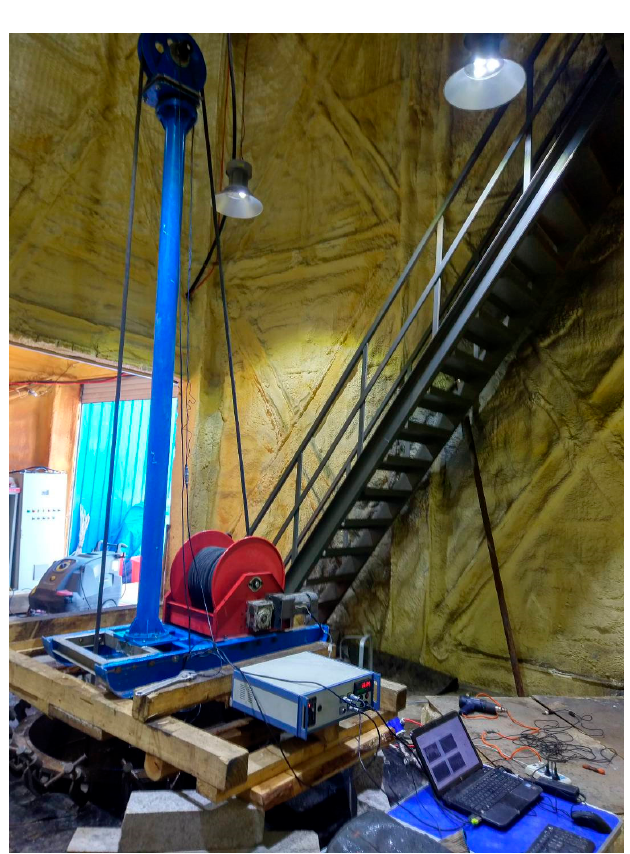
Figure 11. JLU shallow, hot-water, ice-drilling system installed on the drilling testing facility (for more details see Talalay et al., 2018 [15]).